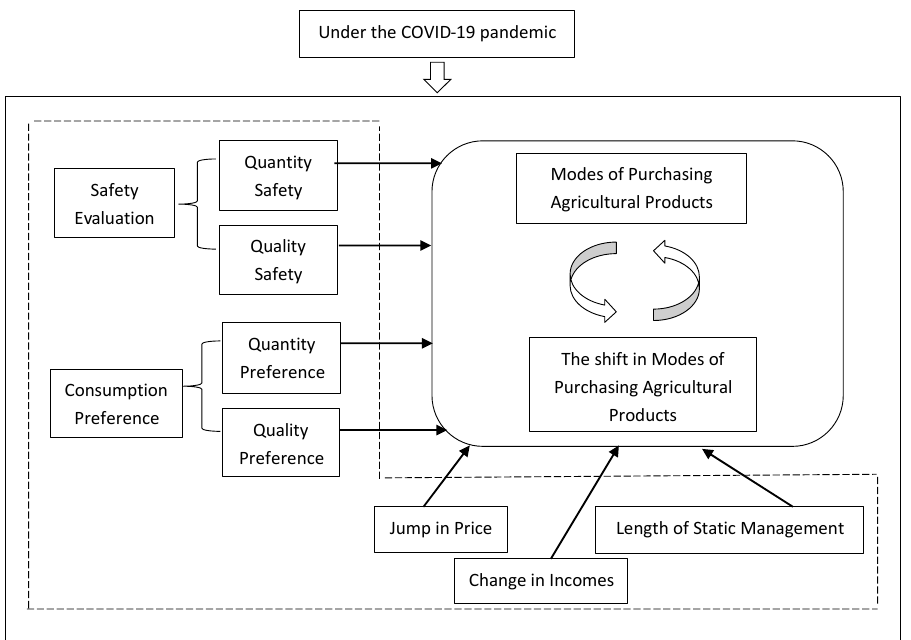
Figure 1. The theoretical model for changes in urban consumers’ ways of buying agricultural products.